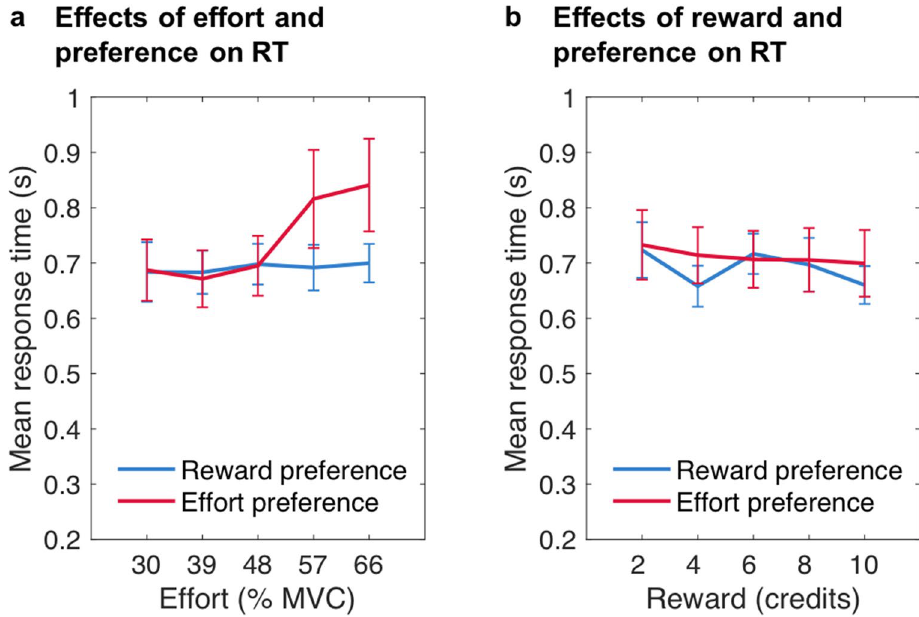
Figure 6. Response times for accepted offers dependent on participants’ general preferences. Mean response times (RTs) in seconds dependent on ( a ) the effort level and ( b ) the reward level of the work offer, as a function of general preference. For illustration, reward preference depicts response times from participants who chose to first see reward information in at least 80% of all trials, while effort preference depicts response times from those participants who chose to first see effort information in at least 80% of trials. Note that here the slope of the effort predictor was significantly higher for effort preference compared to reward preference, t = 3.035, p = .003. Error bars represent standard errors of the